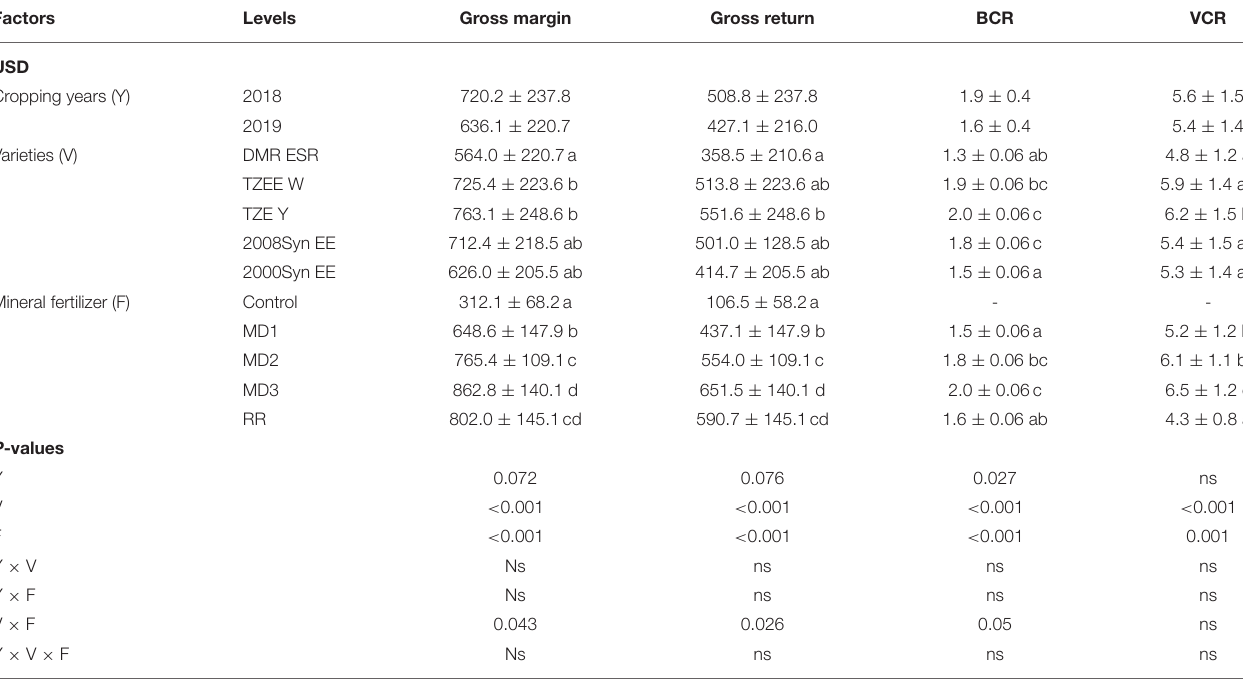
TABLE 5 | Gross margin (GM, USD), gross return (GR, USD), benefit-cost-ratio (BCR), and value-cost-ratio (VCR) (mean ± standard error) as affected by the cropping years, varieties, and mineral fertilizer. Factors